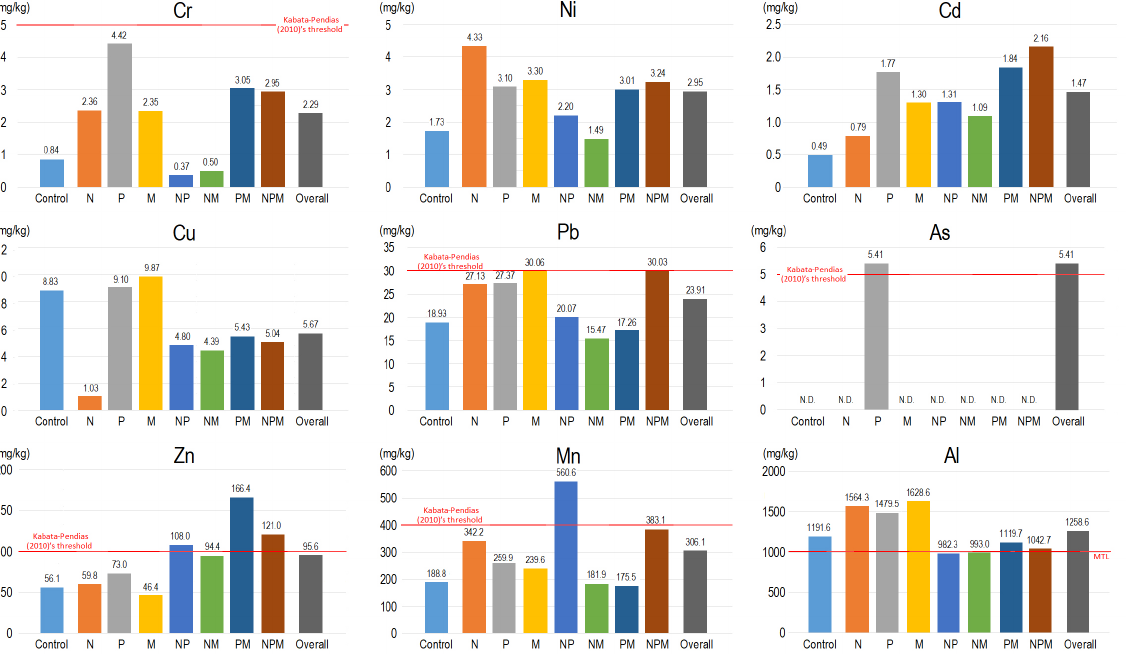
Figure 4. Metal levels of the below-ground biomass of bermudagrass under 25% sludge loading rate and different fertilization treatments in DG. (Note: N.D. = not determined due to insufficient amount of sample for